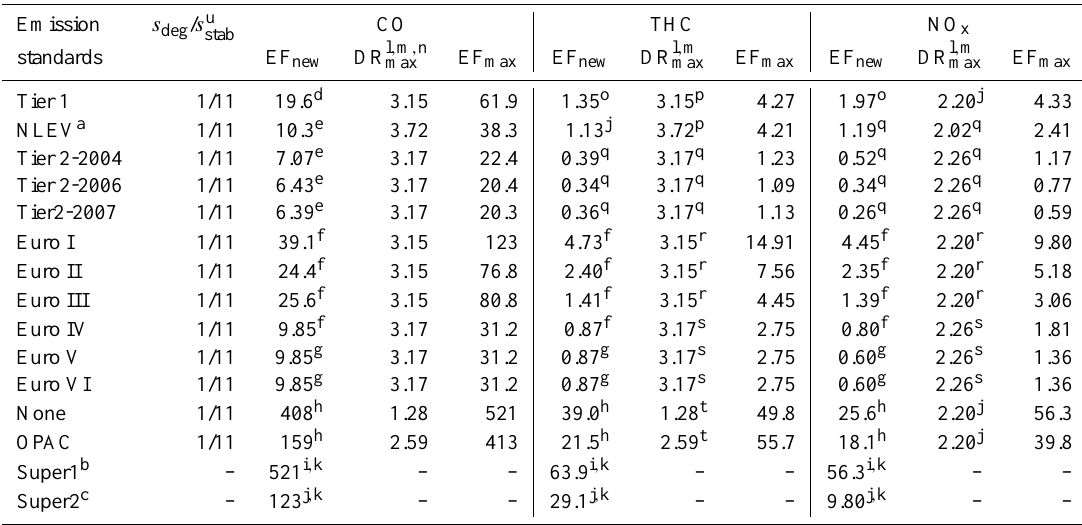
Table 2. Gaseous emission factors (unit: gkg − 1 ) and degradation rates for LDGVs. Emission s deg / s u